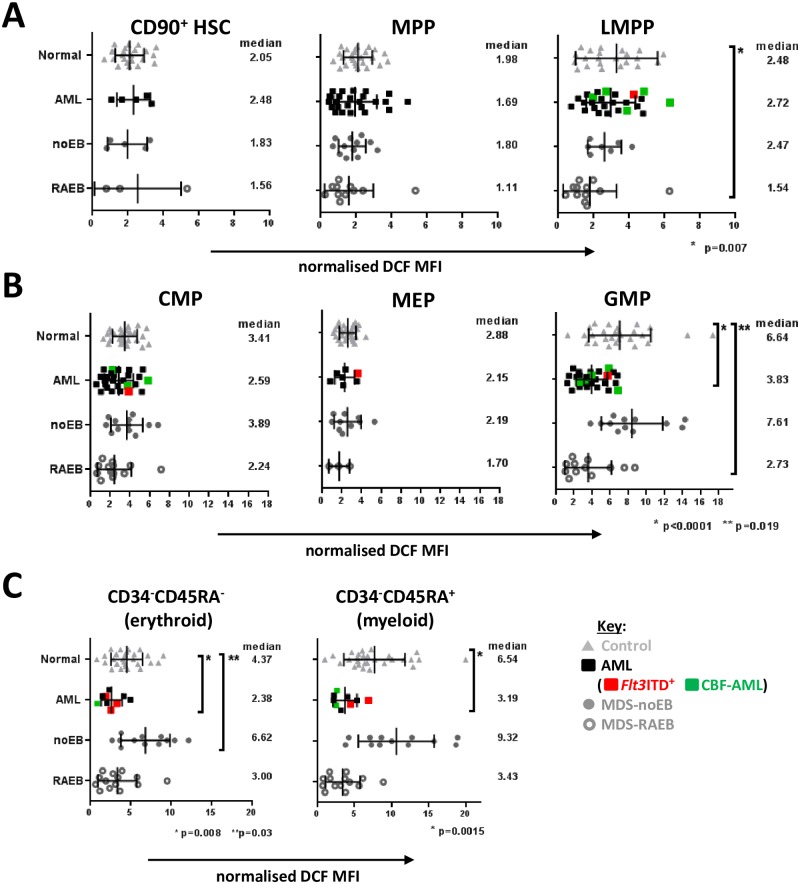
Summarised ROS levels in control, dysplastic and leukemic CD34+ and CD34− blasts.Charts show normalised DCF MFI (relative to lymphocytes within each sample) of CD34+CD38low subsets (A) and CD34+CD38high subsets (B) from control BM (n = 24), and AML BM (n = 27), MDS/MPD-no-EB BM (n = 12) and MDS-RAEB BM (n = 14). Flt3ITD+ AML = red filled square. CBF-AMLs = green filled squares (see Key in figure). ROS levels in CD34−CD117+ cells were also compared between control BM and CD34− AML (n = 10) and MDS patient BM samples, using the same colour scheme as above (C). CD34−CD117+ cells were subdivided into CD45RA+ and CD45RA−cells to enrich for myeloid and erythroid precursors respectively. Median expression and interquartile range is shown on each plot. P values are shown for data-sets where significant differences were observed (p<0.05, Mann Whitney test with 95% confidence intervals).